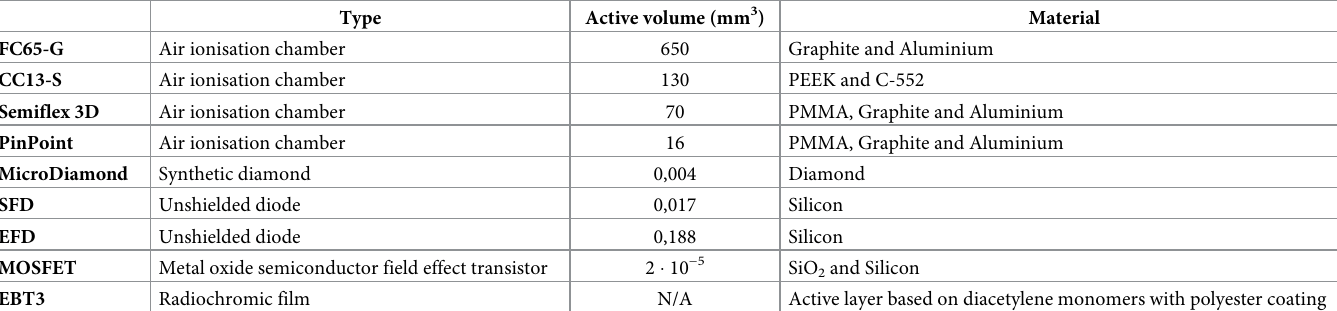
Table 1. Characteristics of the different